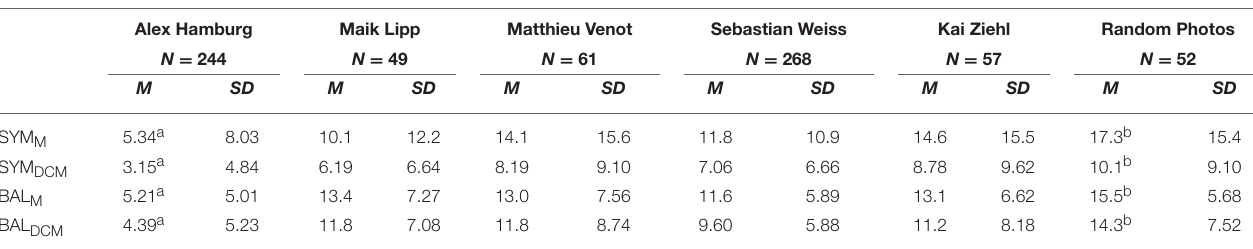
TABLE 5 | Means and standard deviations for all